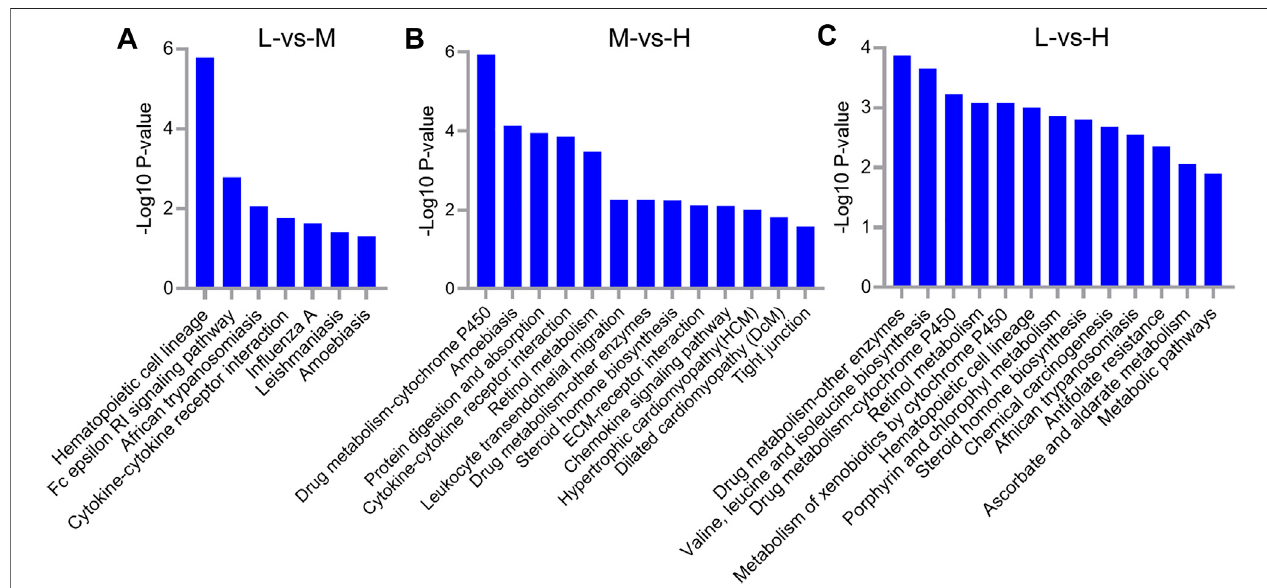
FIGURE 7 | KEGG pathway analysis for differentially expressed genes (DEGs) between L and M (A) , M and H (B) , and L and H (C) . A portion of the signi fi cantly enriched pathways is shown.